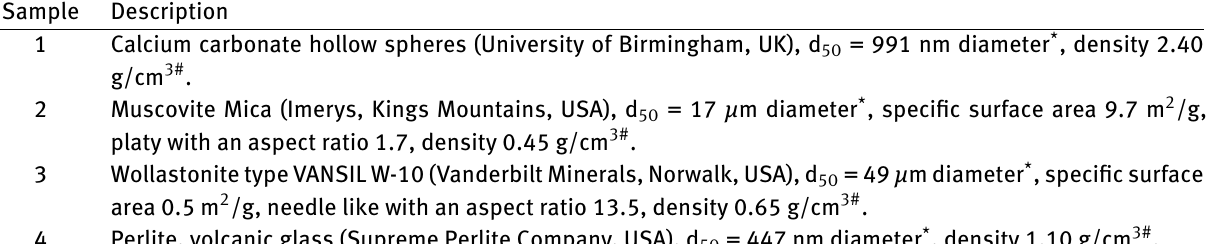
Table 1: Studied mineral samples labelling and description